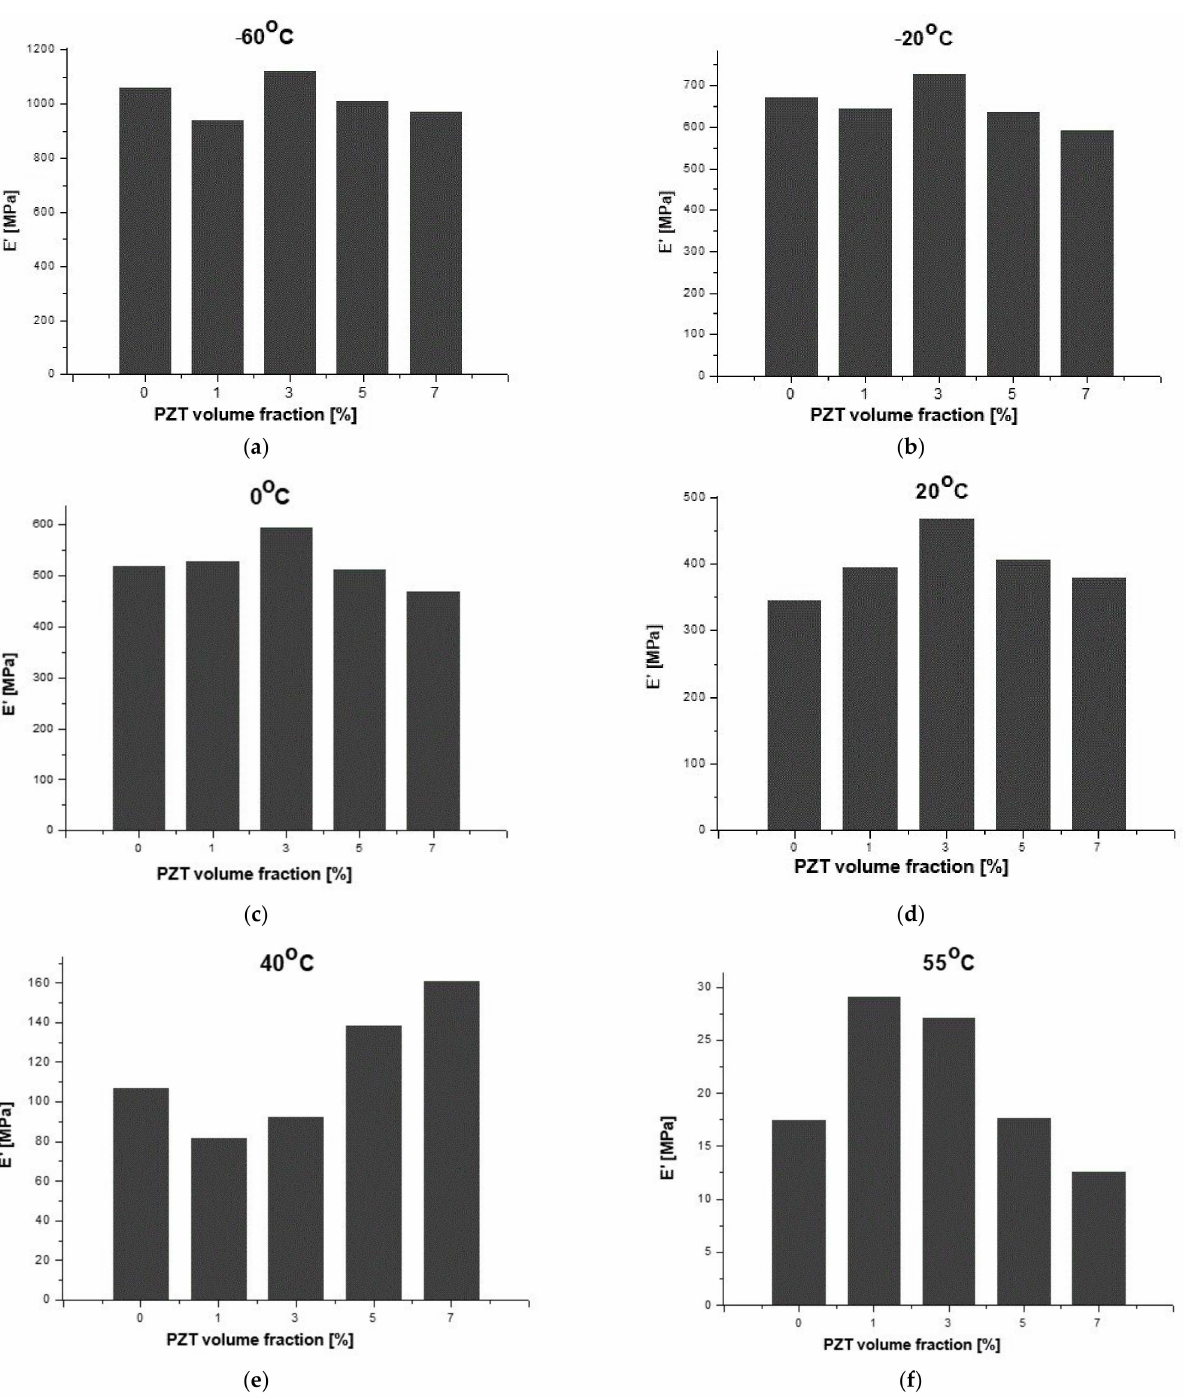
Figure 12. Qualitative evaluation of storage modulus (E (cid:48) ) of SNa0 and SNaPZT# films at different values of temperature: ( a ) − 60 ◦ C, ( b ) − 20 ◦ C, ( c ) 0 ◦ C, ( d ) 20 ◦ C, ( e ) 40 ◦ C and ( f ) 55 ◦